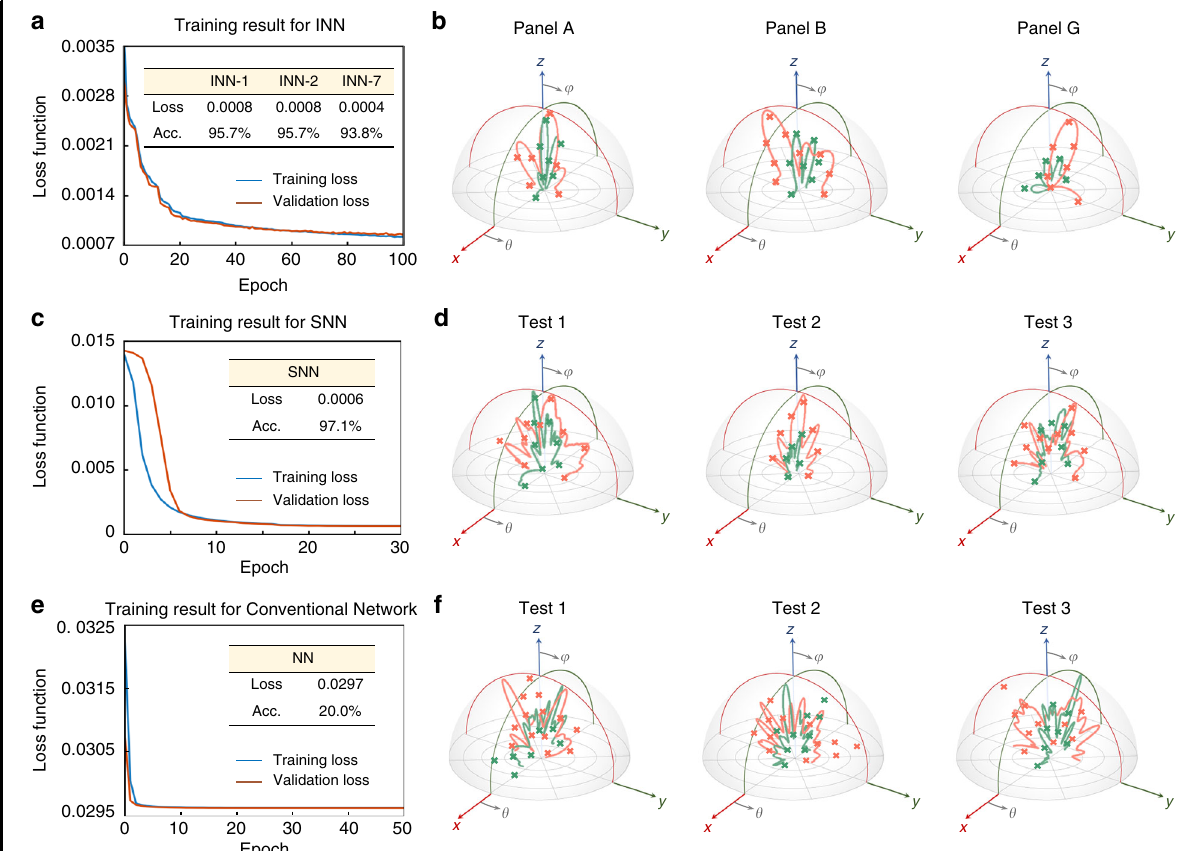
Fig. 3 Training results and the comparison with a conventional neural network. a The training results for INN-1 over the epoch, with an accuracy of 95.7%. The accuracies for INN-2 and INN-7 are 95.7 and 93.8%, respectively. More results of the INN are left in Supplementary Note 2. The blue and red lines represent the training and validation losses, respectively. b The predicted RCS results of INN, where the three samples are selected from Panel A, Panel B, and Panel G, where the green color is for cross 1 and orange for cross 2. c The training results for the SNN over the epoch, with an accuracy of 97.1%. d Predicted RCS results of three samples by the knowledge inheritance paradigm. The predicted results are derived from the predicted meta-atoms. e The training results for the conventional neural network over the epoch. It is in a serious under fi tting state, and the accuracy is only 20.0%. f Predicted RCS results of the three samples from the testing